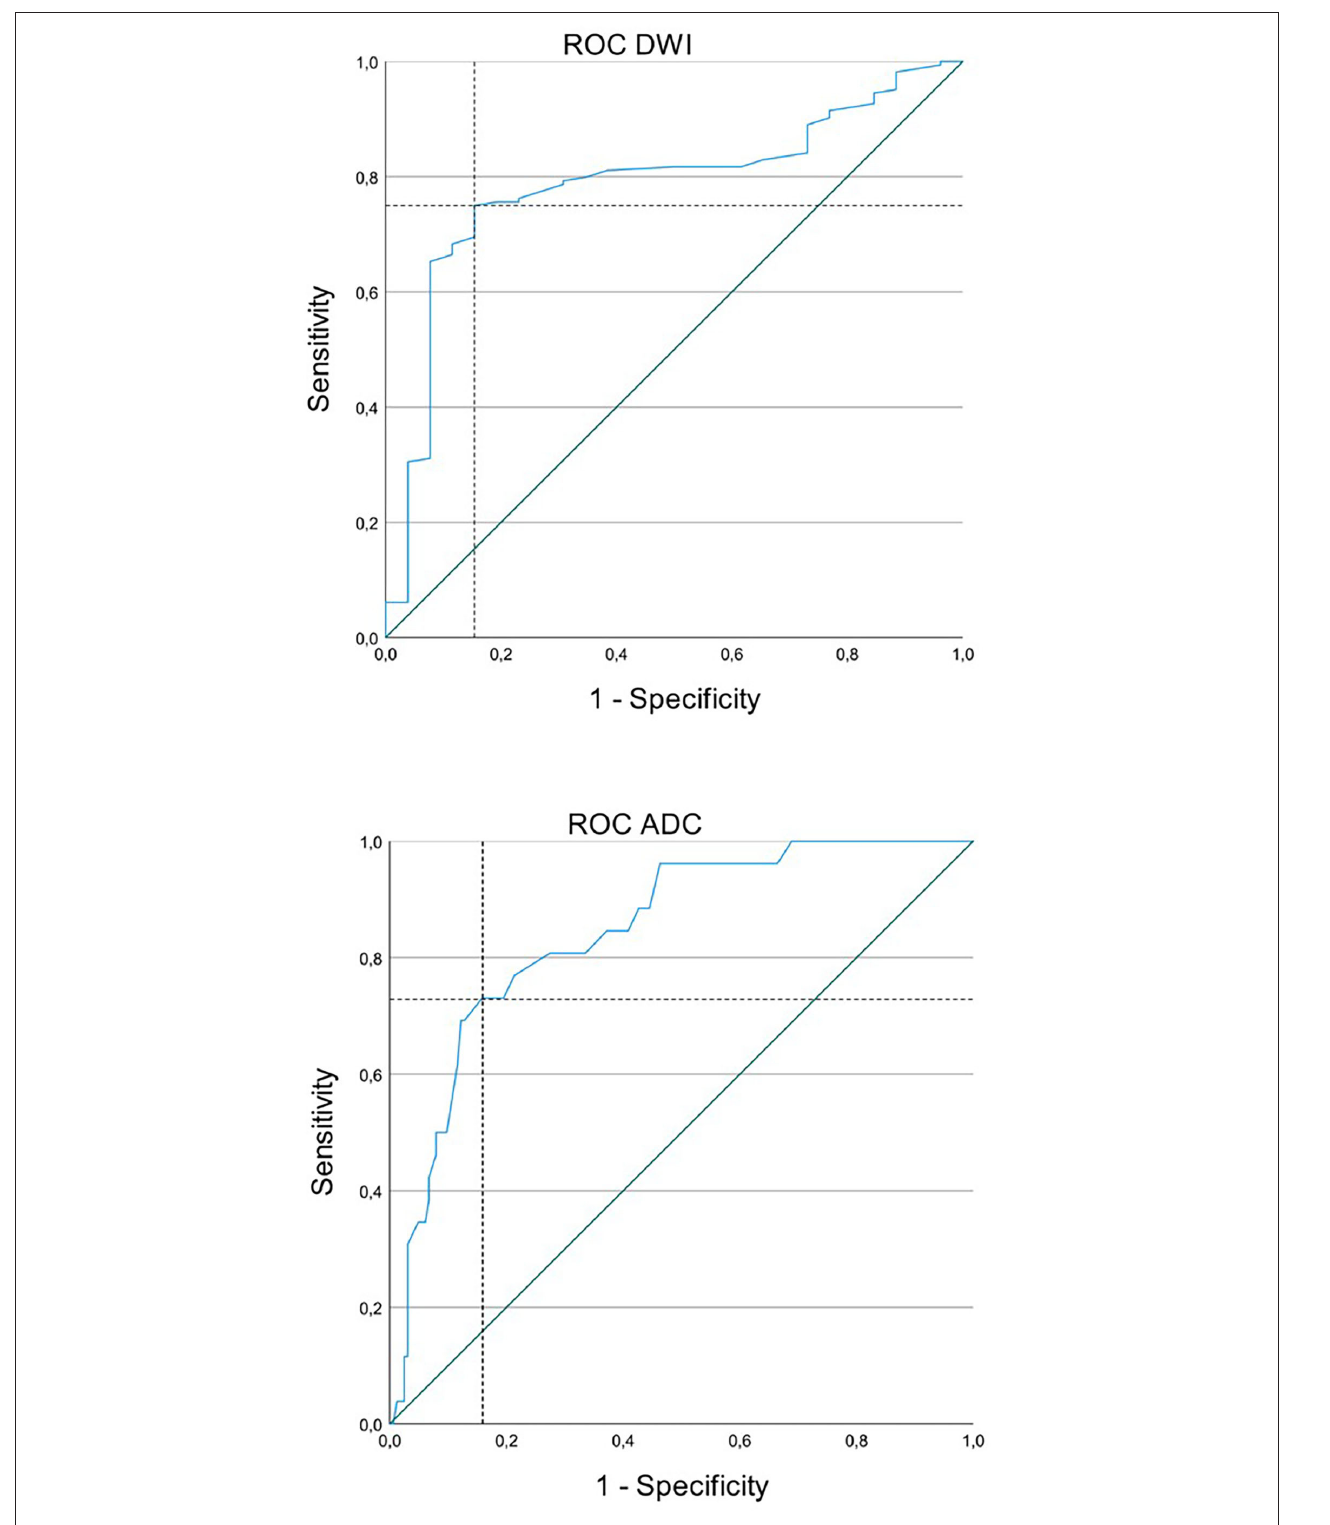
FIGURE 3 | Receiver operating characteristic (ROC) curve for status epilepticus (SE) and acute ischemic stroke (AIS) with diffusion restriction and apparent diffusion coefficient (ADC) signal decrease. Upper image: The cutoff value for diffusion-weighted imaging (DWI) was 1.495 with a sensitivity of 75.0% and a specificity of 84.6%. Lower image: The cutoff value for ADC was 0.745 with a sensitivity of 73.1% and a specificity of 84.1%.